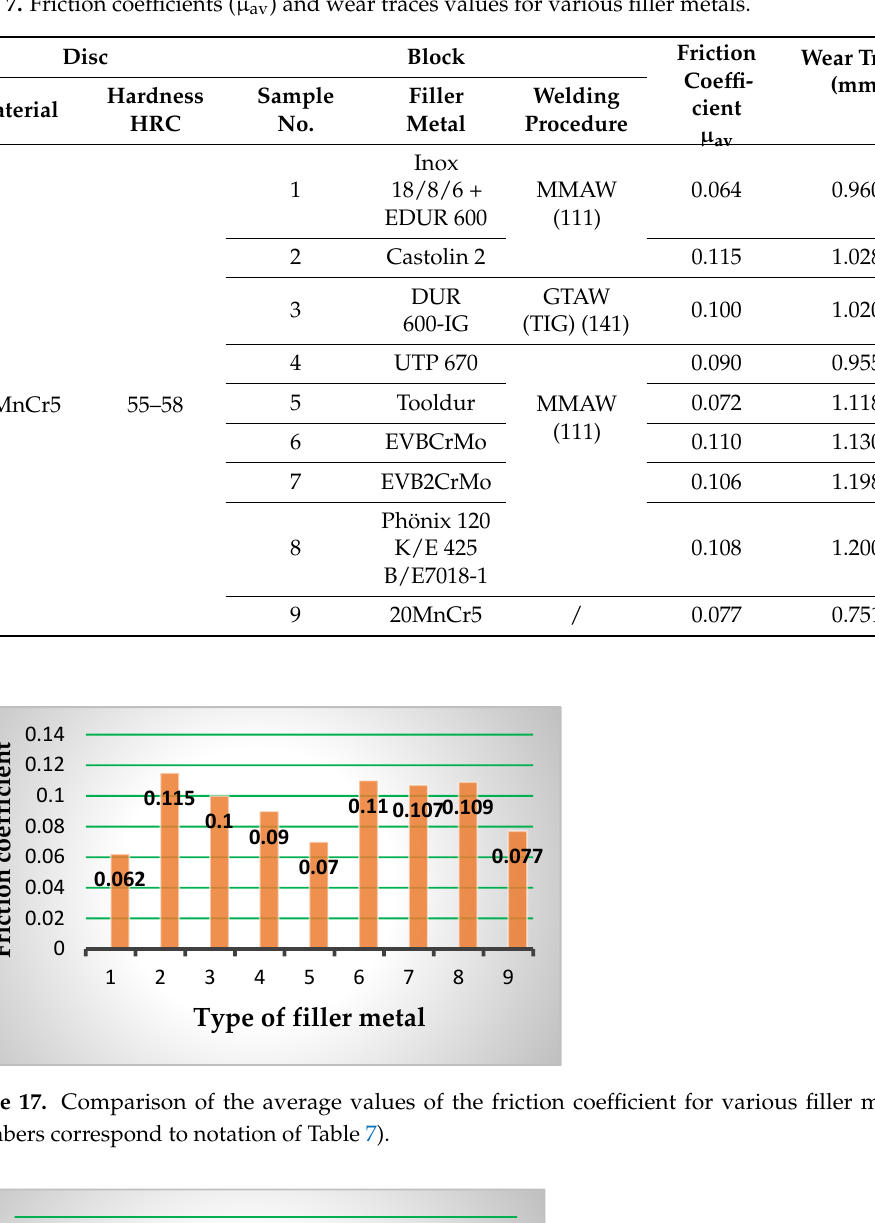
Table 7. Friction coefficients ( μ av ) and wear traces values for various filler metals.